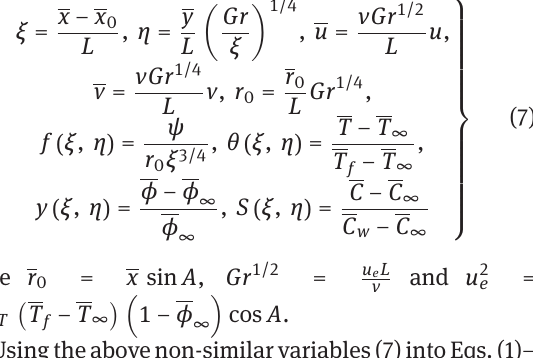
Fig. 1: Geometry of the problem